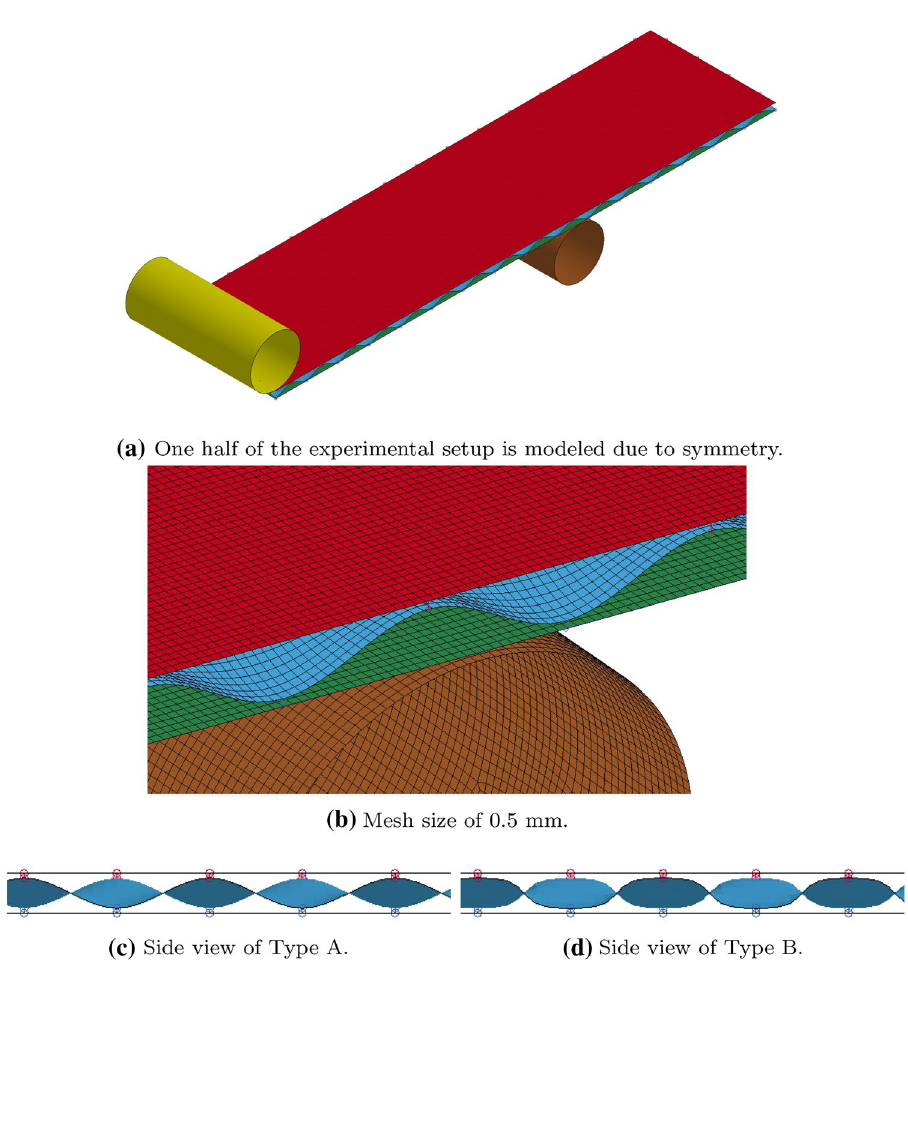
Fig. 5 Detailed finite element model of three-point bending of Type A